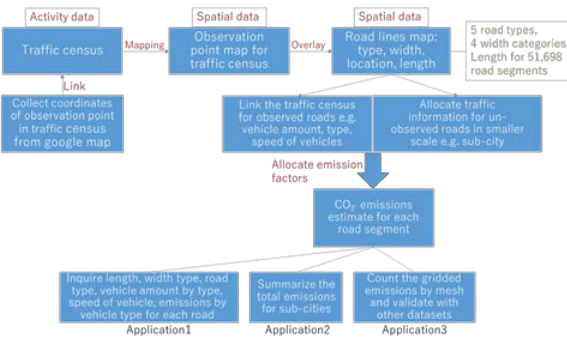
Figure 1. Flow chart on road traffic emissions mapping